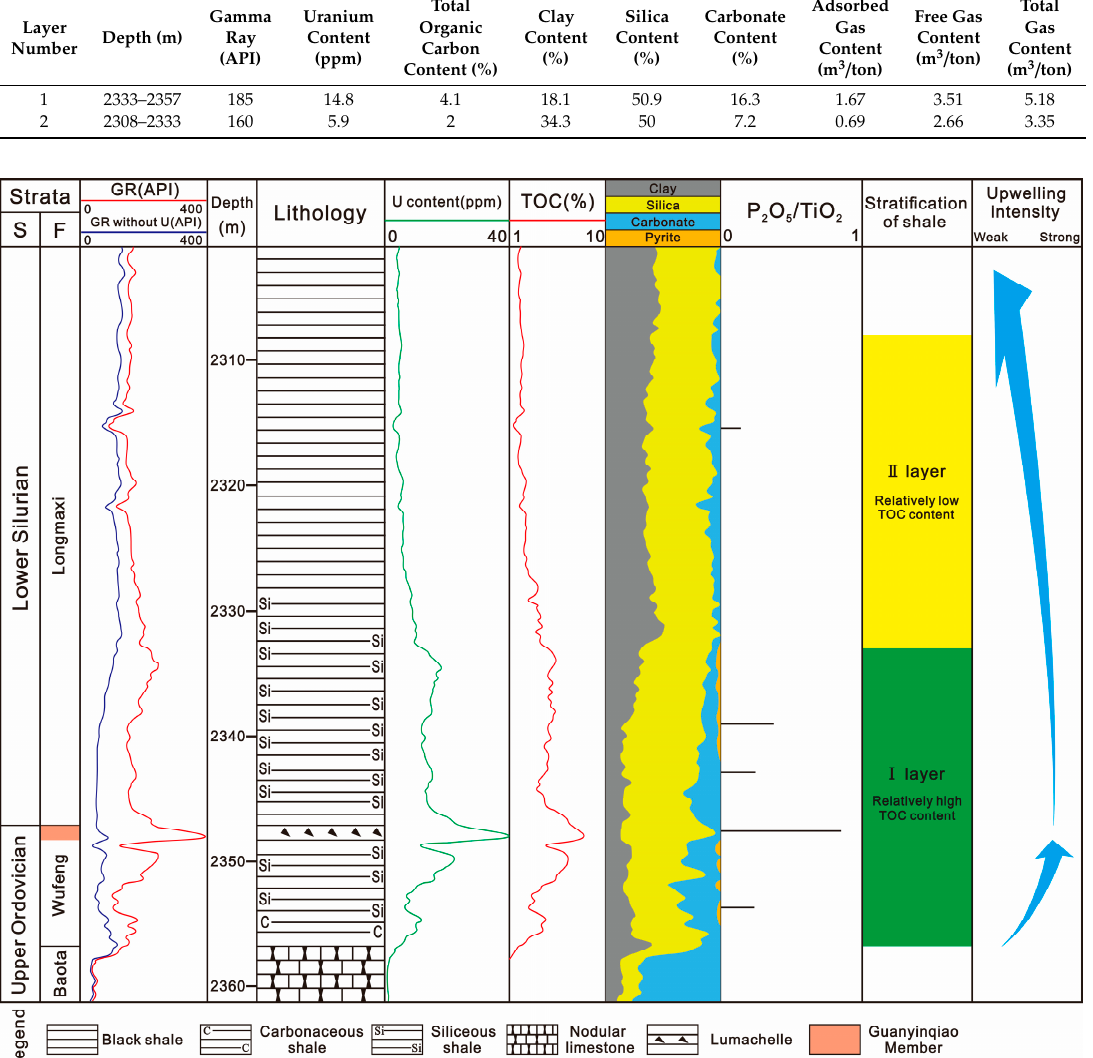
Figure 3. Comprehensive stratigraphic profile of Upper Yangtze Well N211 (the P 2 O 5 / TiO 2 ratio is from the results of Wang et al. [1]). 168